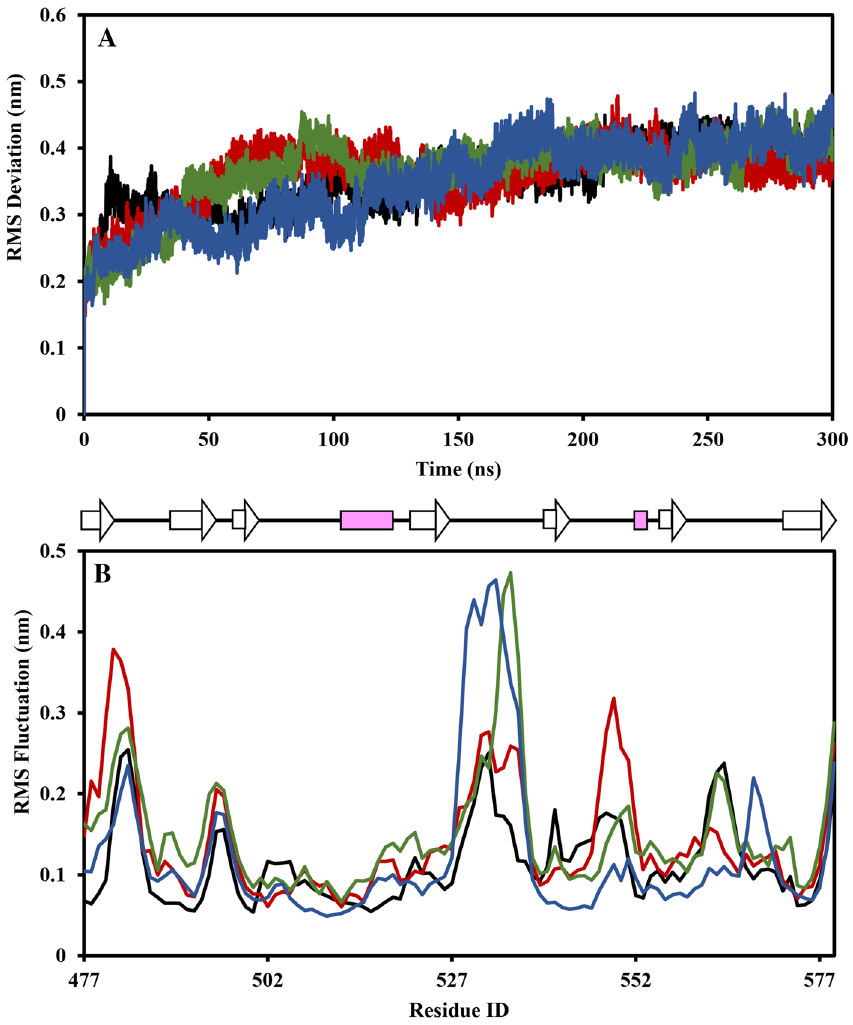
Figure 1. RMSD ( A ) and RMSF ( B ) of unbound and bound SRCR5 forms with three inhibitors: (black represents unbound SRCR5, red represents SRCR5-brazilin, green represents SRCR5-catechin, blue represents